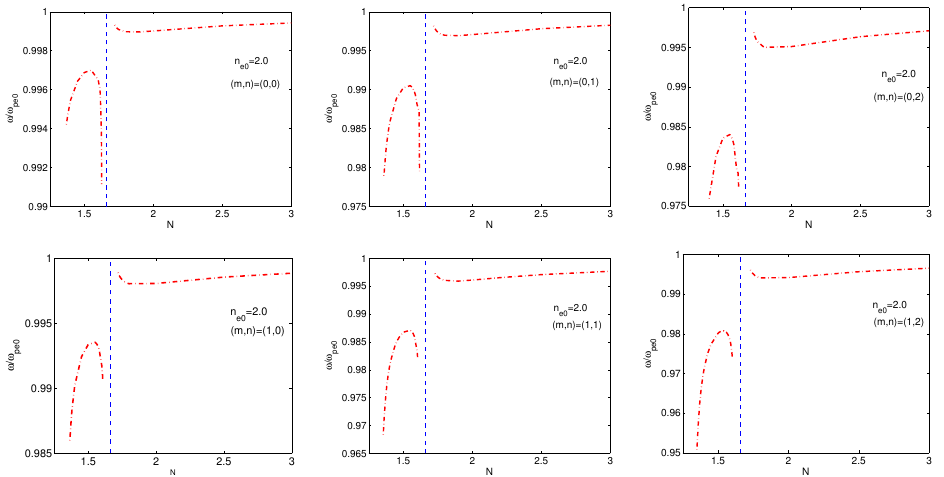
Figure 9: Cold plasma dispersion relation with respect to the longitudinal refractive index N for the first few modes.